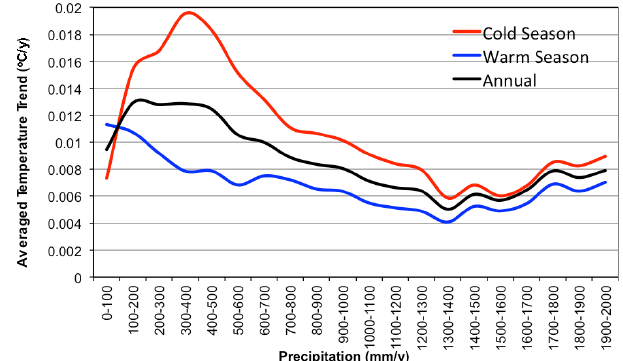
Fig. 6. Same as Fig. 5 but for 20–60 ◦ N. Table 1. The warming amplitude of temperature over semi-arid re- gion for different areas, where Global is defined as global land, NH is the Northern Hemisphere, North America is the region of